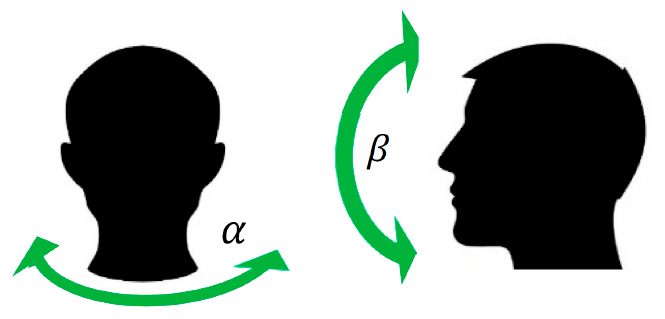
Figure 20. Head rotation measured by α and head inclination measured by β .